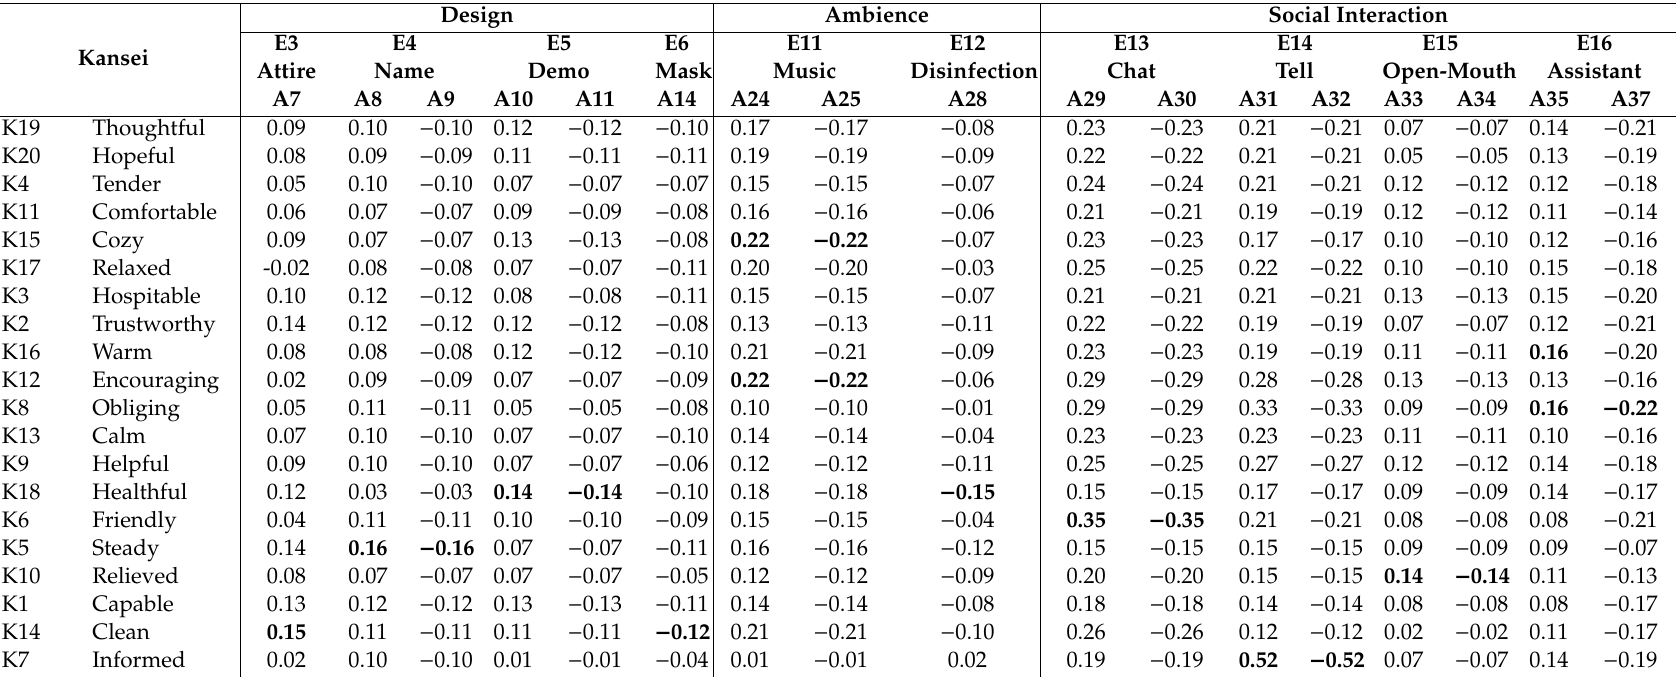
Table 5. Cross-loading of significant healthscape attributes on Kansei ( p <